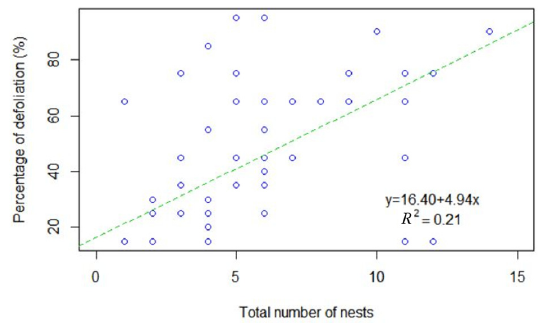
Figure 8. Relationship between the total number of nests and percentage of defoliation measured